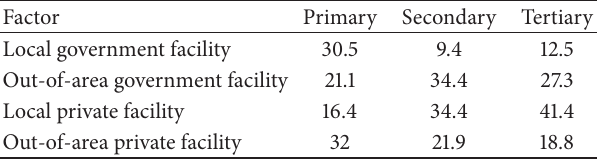
Figure 3: Frequency of Canadian physicians with or without personal and family history of mental illness ( 𝑁 = 128 ).